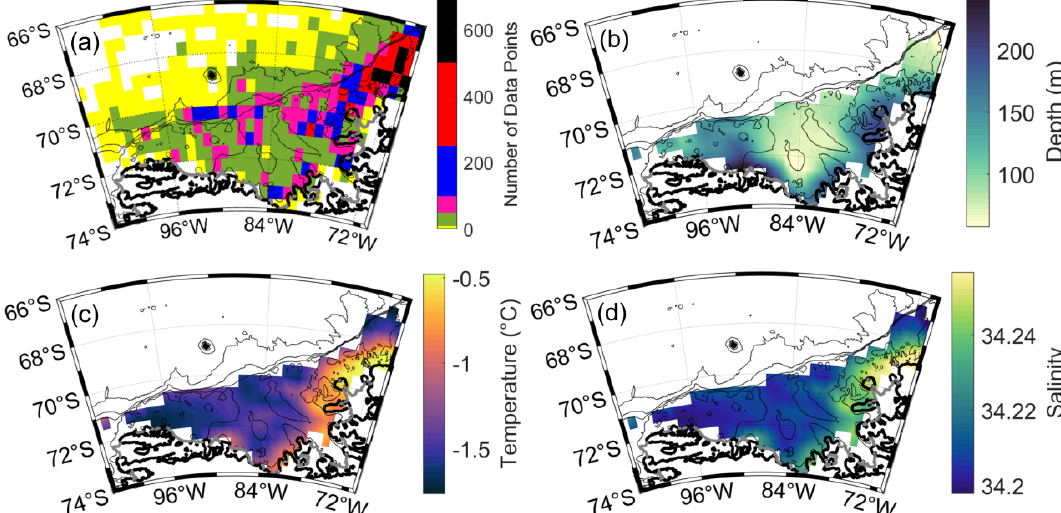
Figure 4. Mean spatial distribution of winter water (WW) properties in the Bellingshausen Sea. The map is constructed using a grid spacing of 0.5 ◦ latitude and 1 ◦ longitude. (a) The number of data points within each grid cell (white represents a grid cell with no data). (b–d) Depth (meters), potential temperature (degrees Celsius), and salinity, respectively, on the 27.4kgm − 3 isopycnal.